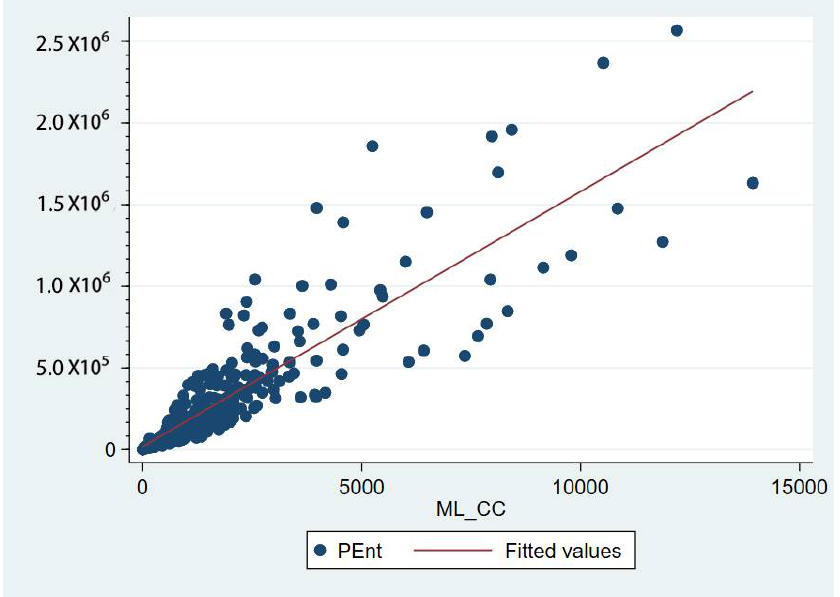
Figure 4. Relationship between circulation of books and entrepreneurship. Source: China Statistical Yearbooks, China Economic Census Yearbook and the website of Chinese Intangible Cultural Heritage.